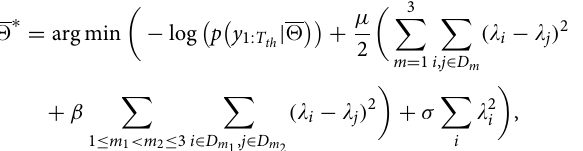
[ 5 ] } 30 k = 1 using Model 5 in k [ 1 ] [ 5 ] } 30 k = 1 using Model 1 in the right panel. The superscripts k